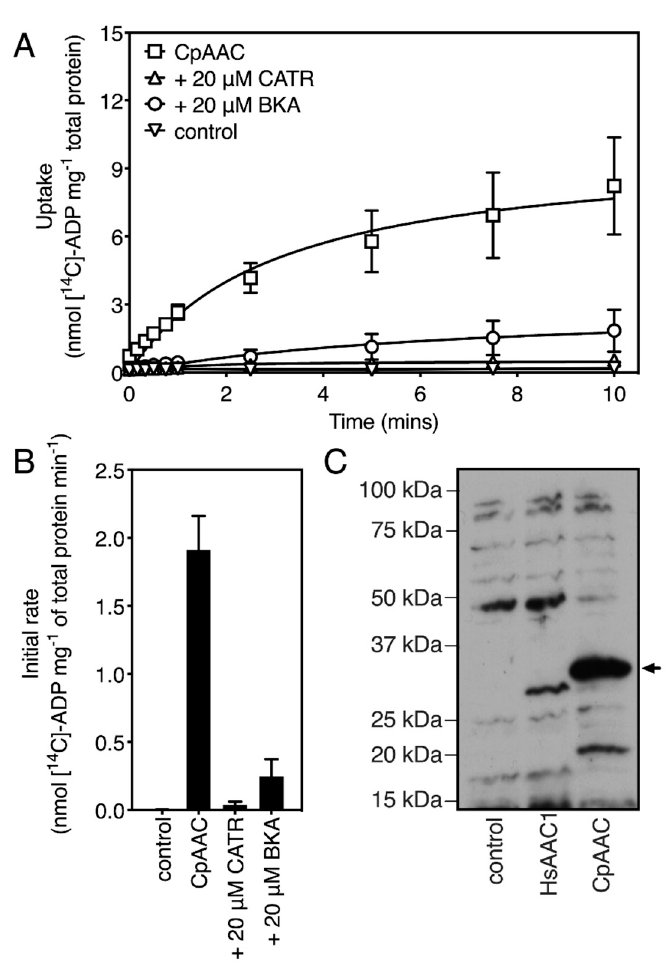
Figure 4. CpAAC expressed in Lactococcus lactis retains functional characteristics of the mitochondrial ADP/ATP carriers. ( A ) ADP transport by CpAAC can be inhibited by carboxyatractyloside (CATR) and bongkrekic acid (BKA), the canonical inhibitors of mitochondrial AACs. Fused membrane vesicles of lactococcal membranes expressing CpAAC were preloaded with 5 mM ADP in the absence (squares) or presence of 20 µ M CATR (triangles) or BKA (circles). The empty vector controls are shown as inverted triangles. Transport was initiated by the addition of 1.5 µ M [ 14 C]-ADP; ( B ) The specific initial transport rates, when the applied chemical gradients of radio-labeled and cold substrates are maximal, are derived from the linear parts of the uptake curves, typically in the first minute, corrected for the amount of protein. The data are represented by the mean and standard deviation of two biological repeats, each performed in quadruplicate; ( C ) Western blot of cytoplasmic membranes of L. lactis strains expressing CpAAC or human AAC1 (HsAAC1), which was characterized previously by [32], or transformed with empty vector. The band of CpAAC (approximately 33 kDa) was detected with a chicken antibody raised against the antigen YPLDTVRRRMMMT and anti-chicken-horseradish peroxidase conjugate. It is marked with an arrow. 10 µ g of total protein was loaded per